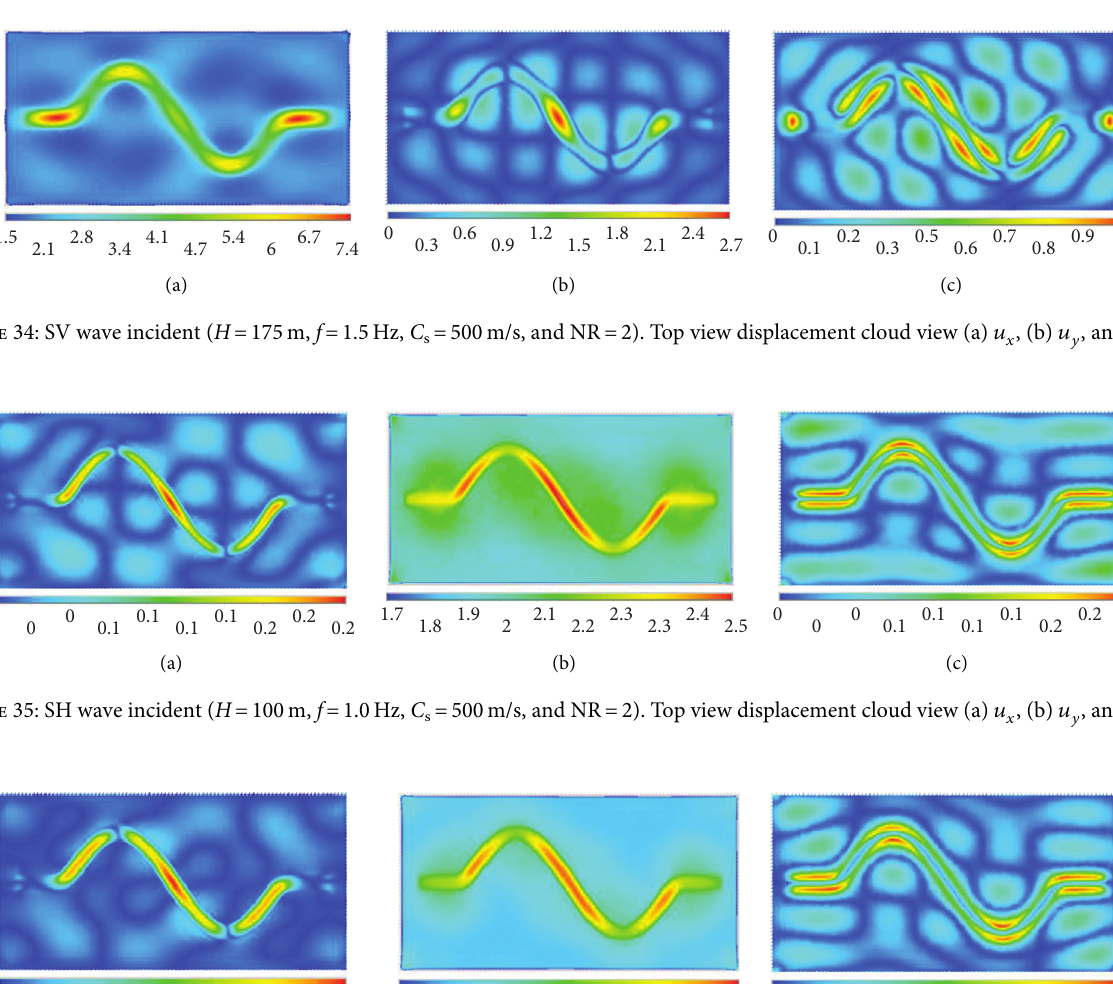
� 500m/s, and NR � 2). Top view displacement cloud view (a) u s